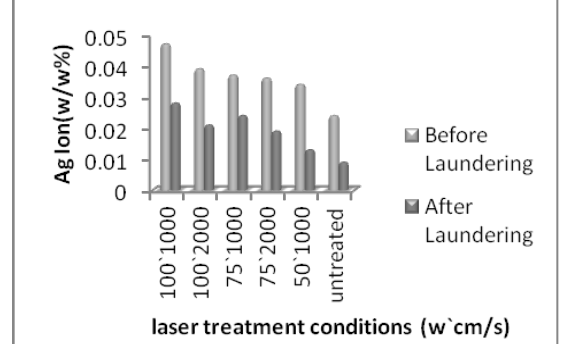
Figure 1. The silver ion content on untreated and laser treated cotton